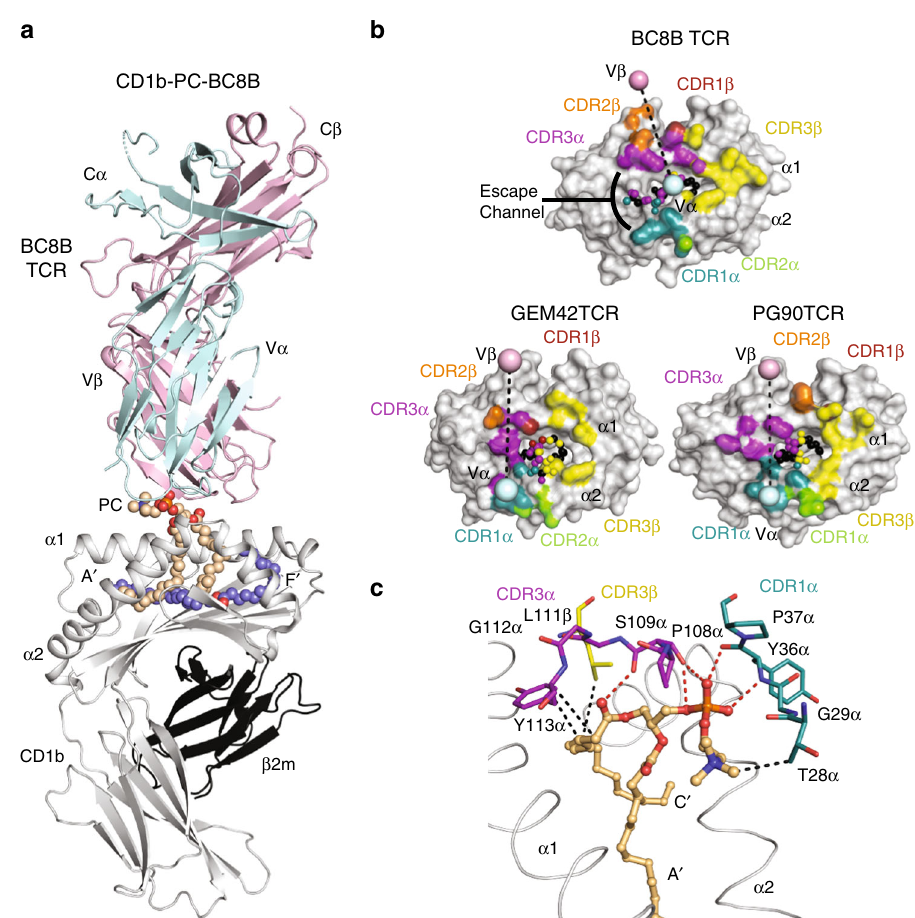
Fig. 4 Overview of the CD1b-PC-BC8B crystal structure. a Overview of crystal structure of CD1b presenting PC in complex with the BC8B TCR. CD1b (gray), β 2 m (black), BC8B TCR α chain (light blue), and β chain (light pink) are represented as ribbons, with PC (light orange) and the scaffold lipid (dark blue) represented as spheres. Dashed lines indicate missing residues in the structure due to lack of electron density. b Footprint of BC8B CDR loops on CD1b-PC, in comparison to the PG90 TCR and GEM42 TCR CDR loops onto CD1b-PG and CD1b-GMM, respectively. CD1b and antigens are represented as gray surface and spheres, respectively, with points of contacts with TCR CDRs indicated as follows: CDR1 α (teal), CDR2 α (green), CDR3 α (purple), CDR1 β (red), CDR2 β (orange), and CDR3 β (yellow). Ligand atoms not contacted by the BC8B TCR are indicated in black. TCR α and β centers of mass are indicated by spheres and colored as indicated in a . Escape channel formed by BC8B TCR CDR1 α and CDR3 β regions is labeled. c Contacts between the BC8B TCR CDR1 α (teal), CDR3 α (purple), and CDR3 β (yellow) regions, CD1b (gray), and the PC antigen (light orange). Amino acid residues involved in contacts are represented as sticks, with the CDR regions, and α 1 and α 2 helices of CD1b represented as ribbons. Hydrogen bonds and hydrophobic interactions are indicated as red and black dashes, respectively. Oxygen, nitrogen, and phosphate ions are colored red, blue, and orange,